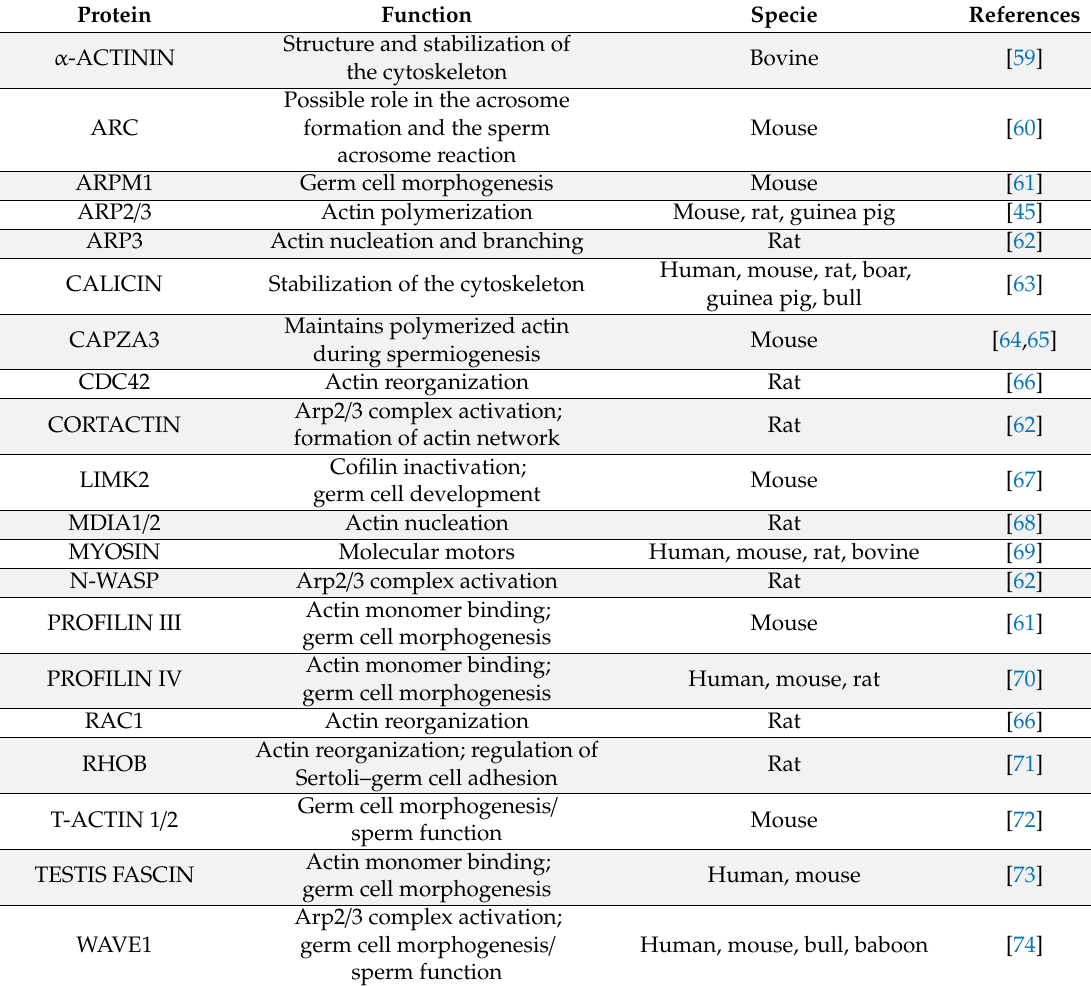
Table 1. Actin-related proteins playing a role during sperm di ff